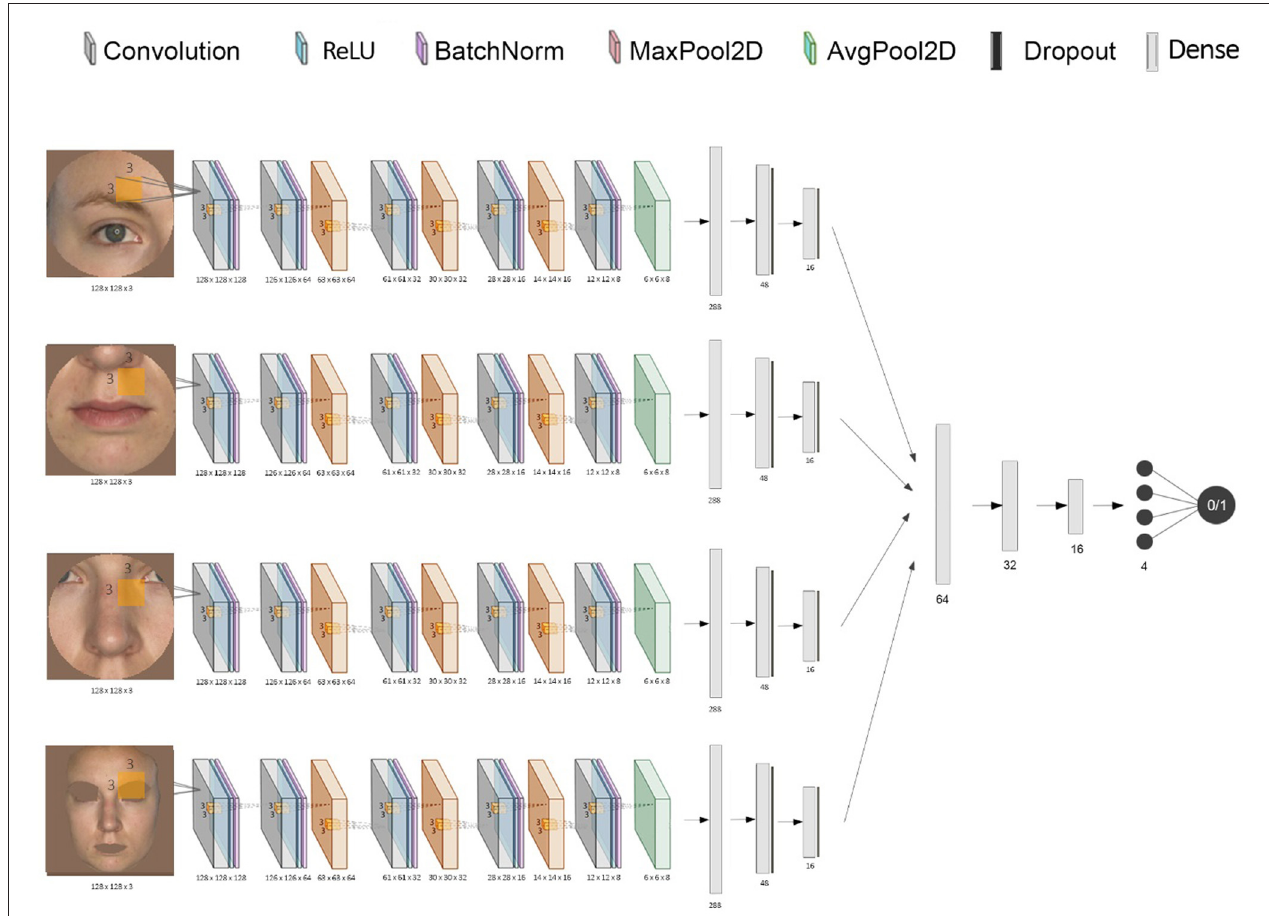
FIGURE 2 | Diagram of the stacked CNN. This shows the combination of each CNN’s inputs and outputs into one final binary classification of “acutely ill” or “healthy”.